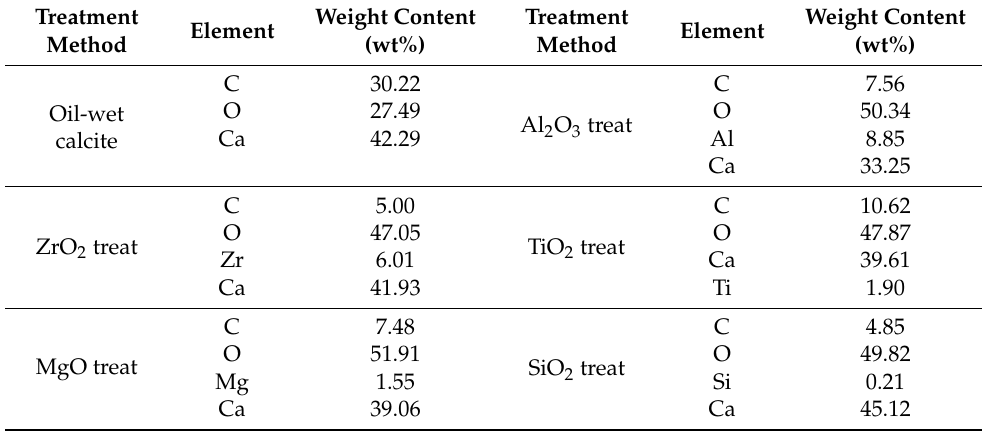
Table 2. EDS analysis of figures of oil-wet calcite modified using five